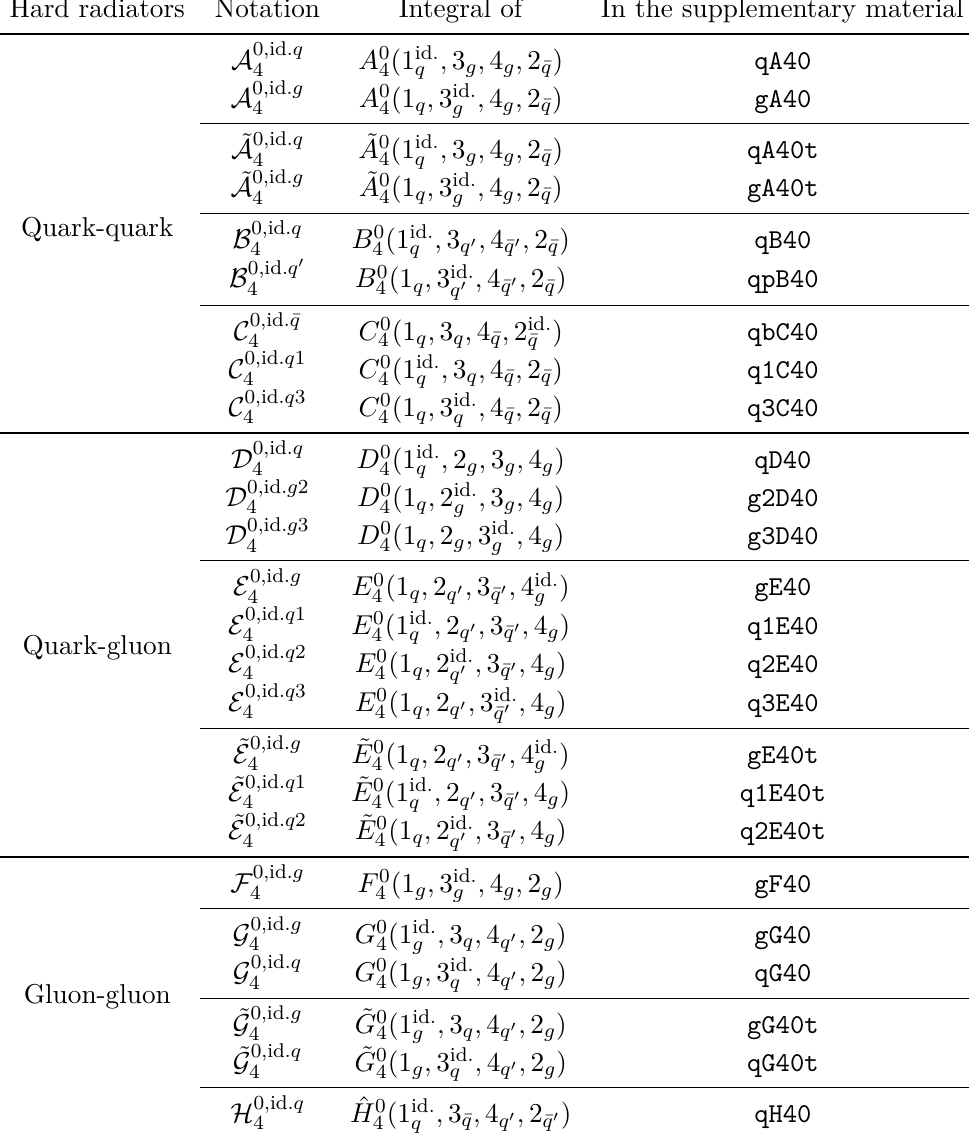
Table 1 . Integrated tree-level four-parton antenna functions X 0 , id .p